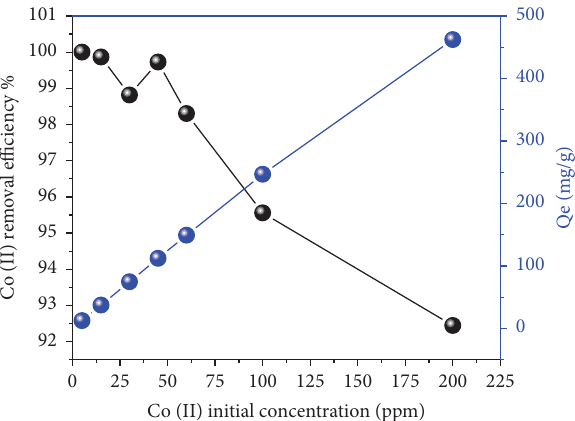
Figure 4: Evolution of the adsorption rate as a function of Co (II) initial concentration by CaO.MgO